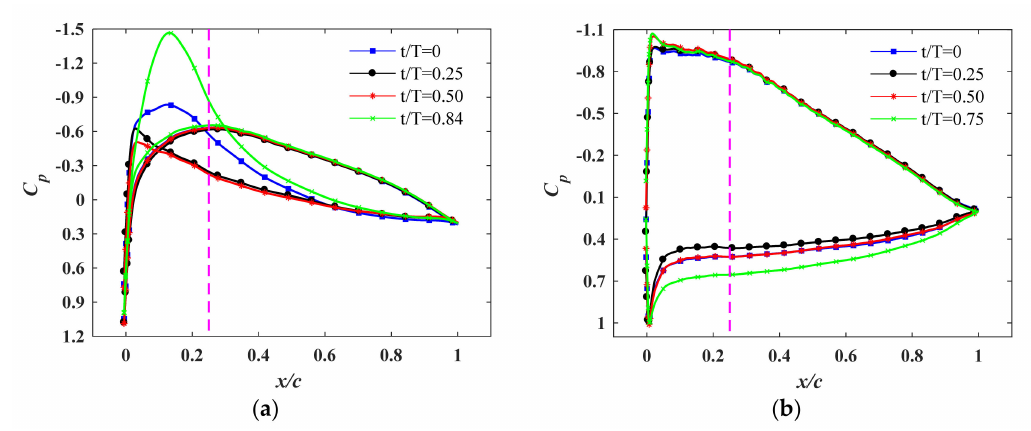
Figure 11. Pressure coe ffi cient distributions on the airfoil of di ff erent moments ( a ) α = 0 ◦ , ( b ) α = 4 ◦